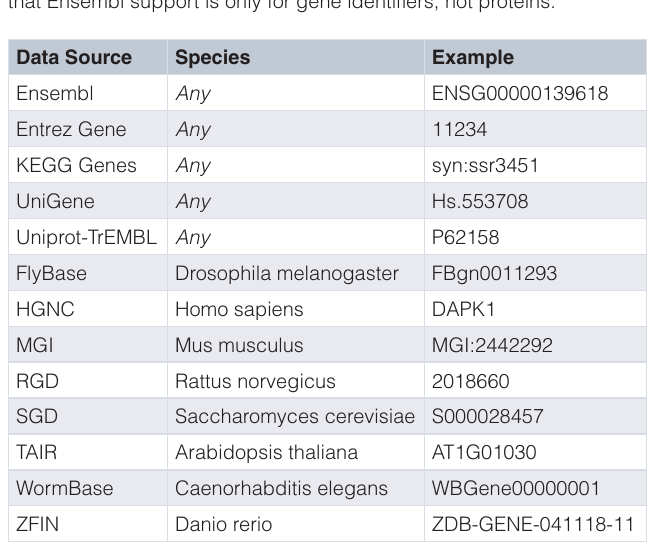
Table 1. Supported Data Sources. The parameter names of supported data sources, their species exclusivity and an example identifier. Note that Ensembl support is only for gene identifiers, not